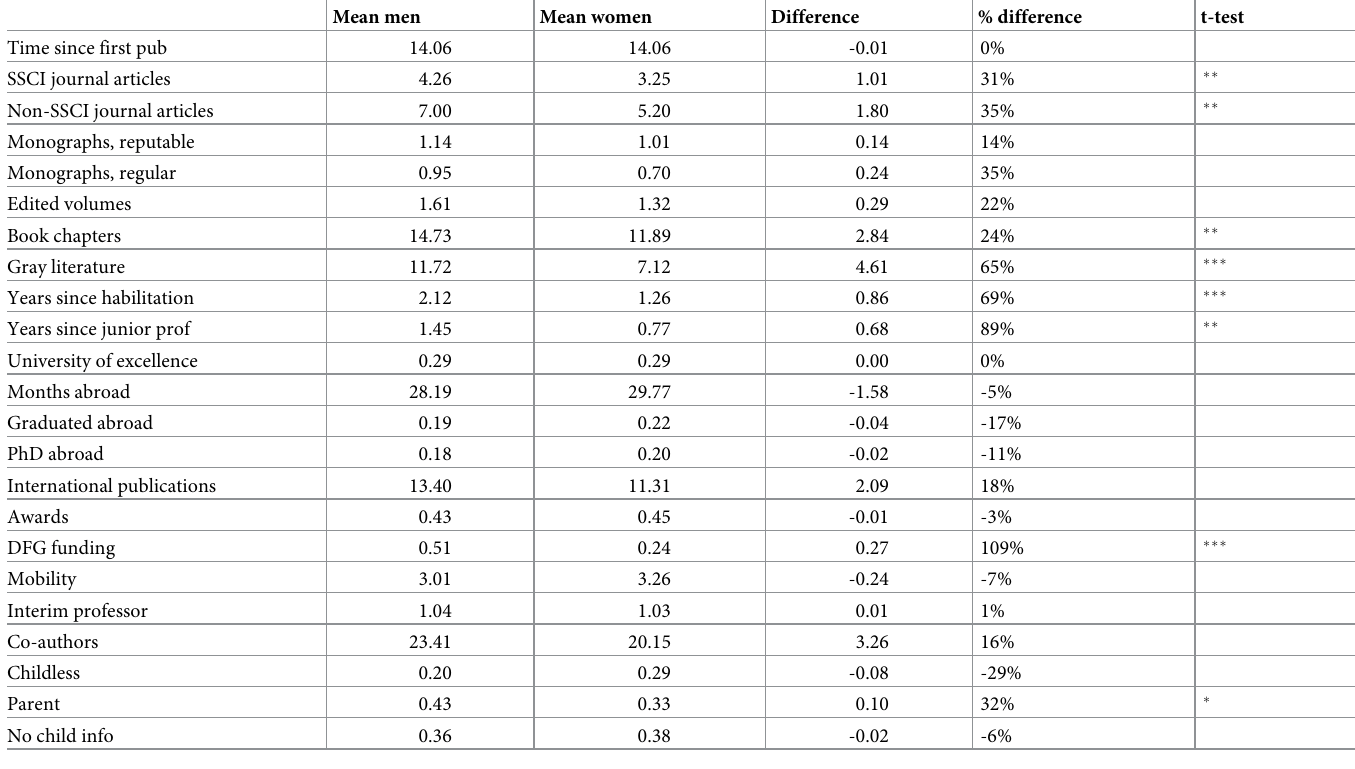
Table 1. What characterizes men and women with complete data that just got